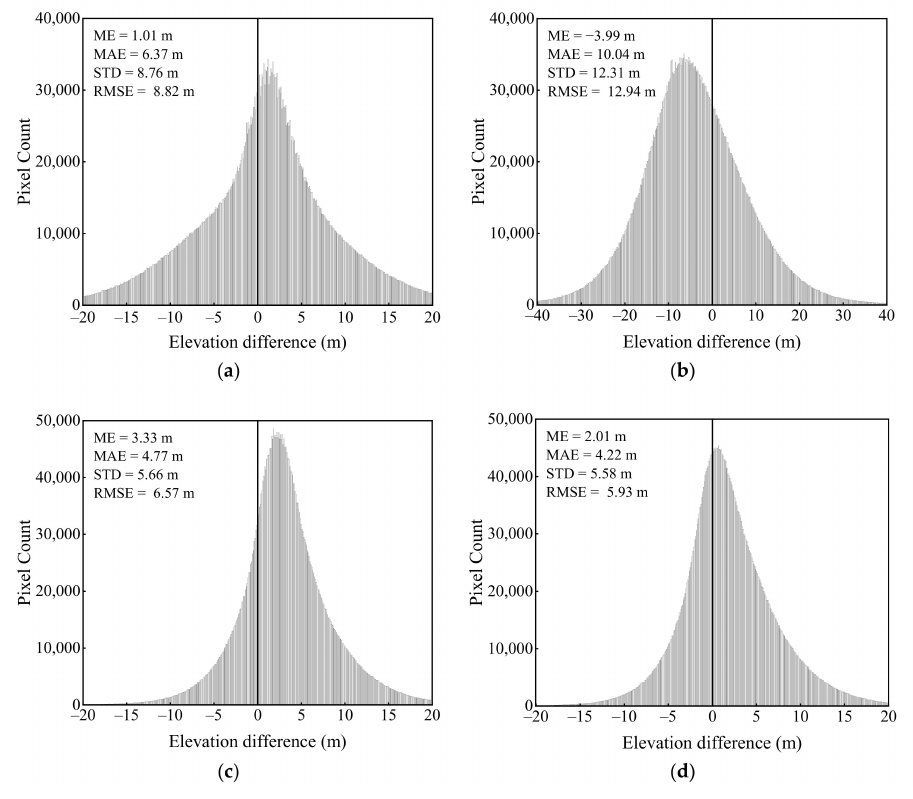
Figure 6. ASTER GDEM V3, AW3D30, Fused DEM, and reference DEM. ( a ) SRTM1 DEM; ( b ) ASTER GDEM V3 DEM; ( c ) AW3D30 DEM; ( d ) Fused DEM.